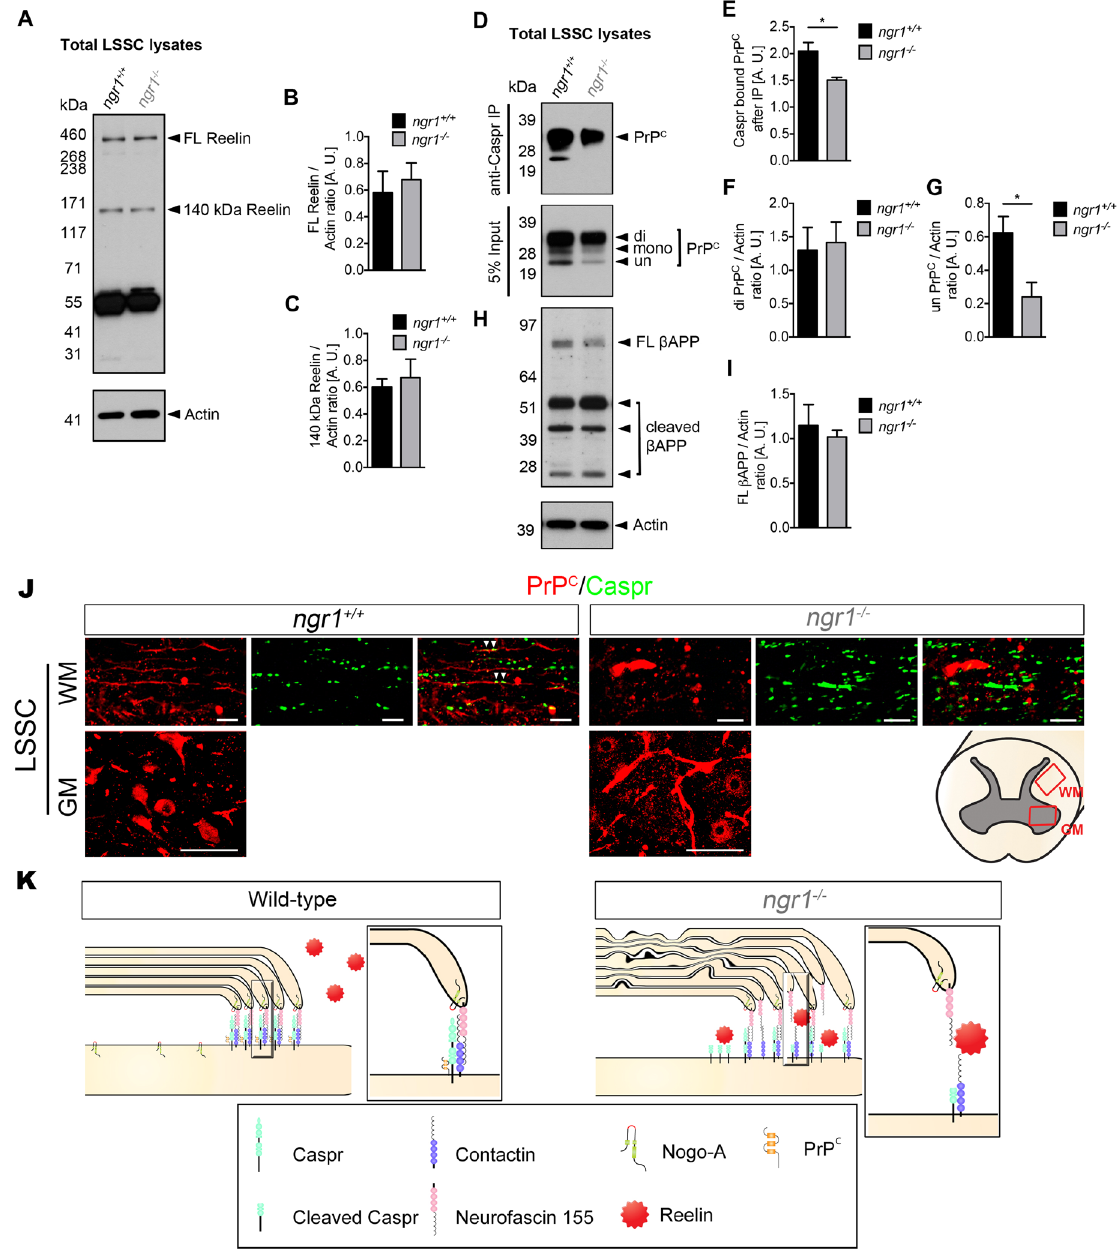
Figure 4. Reduced interaction between PrP C and Caspr in ngr1 − / − mice. ( A – C ) Western blot of LSSC lysates from ngr1 + / + and ngr1 − / − mice showed no difference in Reelin expression. ( A ) Representative immunoblots for Reelin and Actin loading control. ( B ) Densitometric quantification of full-length Reelin (FL Reelin) and ( C ) 140 kDa degradation product of Reelin and Actin respectively. ( D ) Immunoprecipitation of Caspr showed reduced interaction with PrP C in LSSC from ngr1 − / − mice. Western blot for PrP C from 5% input of pre- immunoprecipitation sample showed three bands which represents the three glycosylation states of PrP C ; di- glycosylated (di), mono-glycosylated (mono), and un-glycosylated form (un), respectively). ( E ) Densitometric quantification of total PrP C and Caspr bound PrP C . ( F ) Densitometric quantification of di-glycosylated PrP C , ( G ) unglycosylated PrP C . ( H ) Representative immunoblots for β APP, and Actin loading control. ( I ) Densitometric quantification of β APP and Actin ( * P < 0.05, n = 4 for both genotypes). ( J ) Immunofluorescent images showed axonal PrP C and co-localisation with Caspr within LSSC white matter (WM) of ngr1 + / + whereas, lack of axonal PrP C staining in WM was found in ngr1 − / − mice. PrP C expression in motor neuronal soma within the gray matter (GM) of LSSC was found in both genotypes. Illustration showing where the WM and GM images were taken from LSSCs are shown at the right-hand side (WM scale bars = 10 μ m; GM scale bars = 50 μ m). ( K ) In wild-type, paranodal junction is tightly organised by the putative interaction among glial Neurofascin 155, axonal Caspr and Contactin. Furthermore, tight interaction between Caspr and PrP C inhibits Reelin-mediated Caspr cleavage, which allows for tight compaction of paranodal loops and myelin sheath.